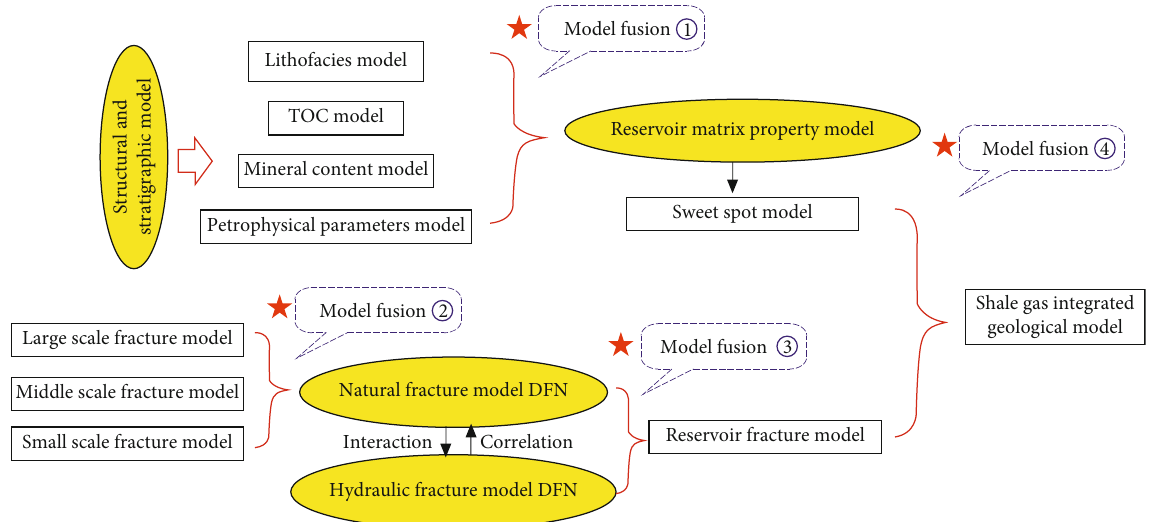
Figure 19: The key links in the establishment of the geological model of shale gas reservoirs. Each link involves the fusion of models, and the method and quality of fusion control the reliability of the fi nal geological